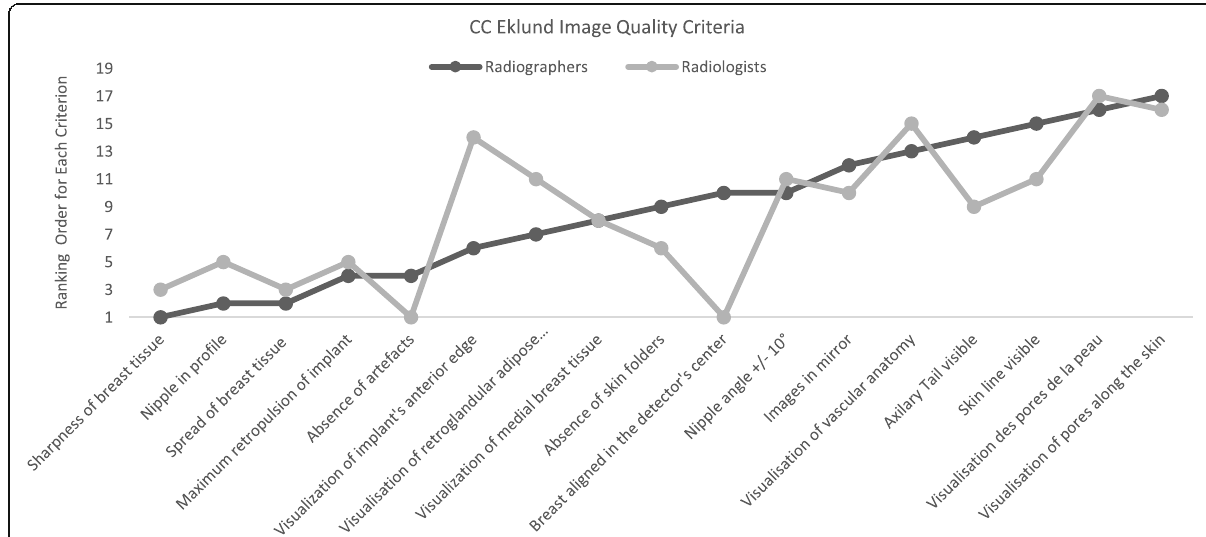
Fig. 2 Average rankings attributed to image quality criteria used to assess craniocaudal (CC) images performed with Eklund Manoeuvre by radiographers and